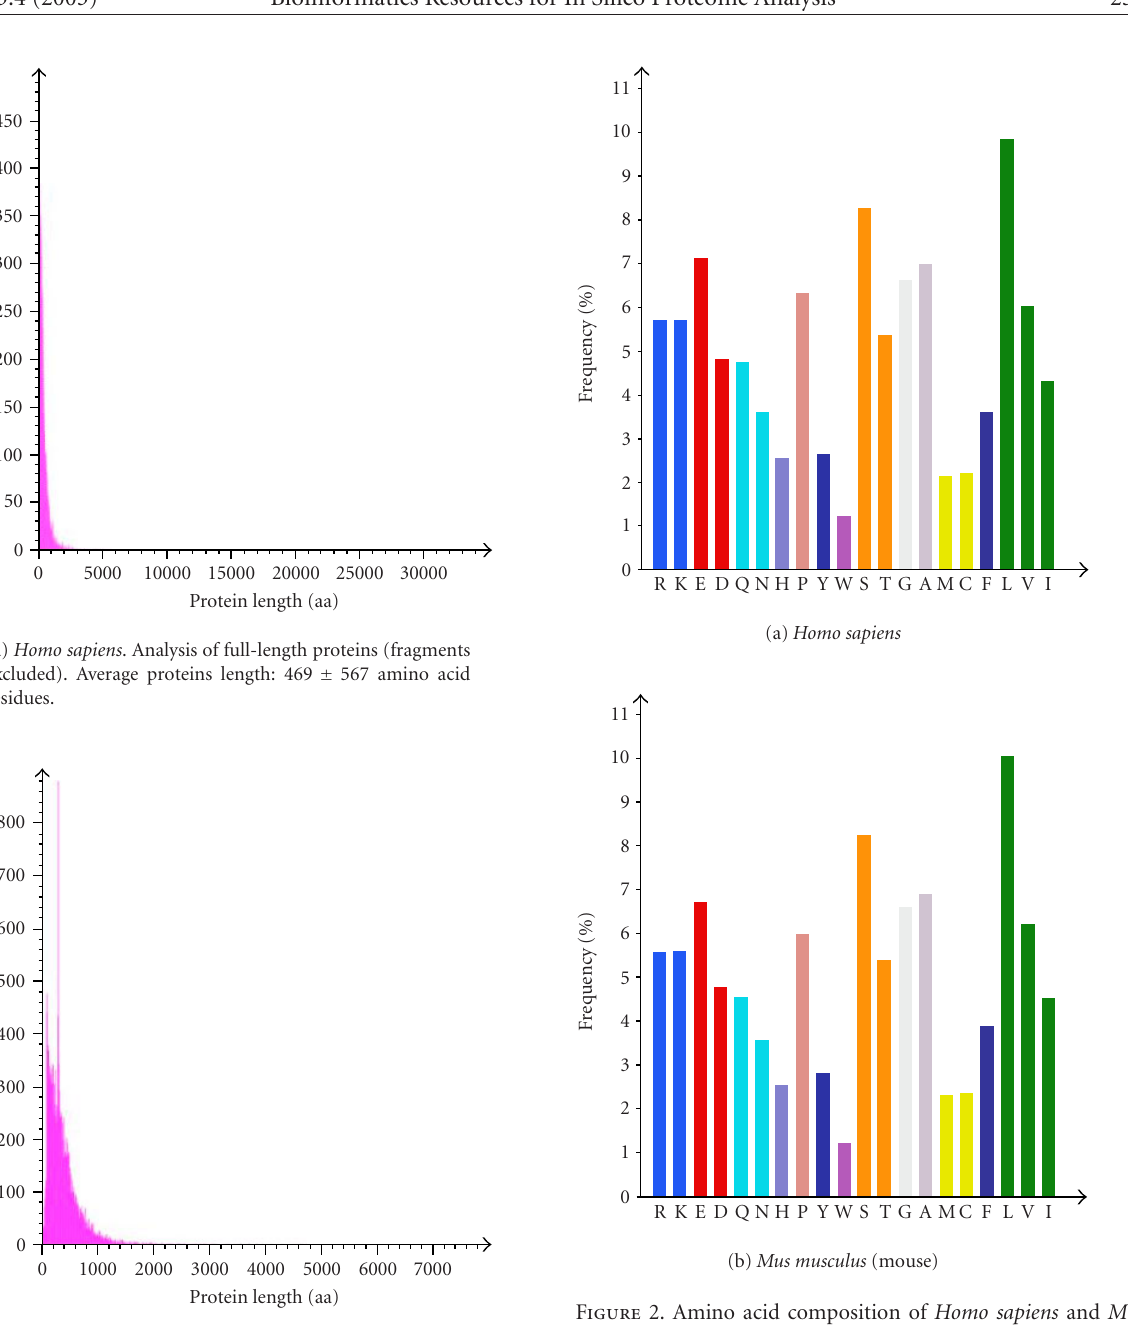
Figure 1. Protein length distribution of Homo sapiens and Mus musculus .